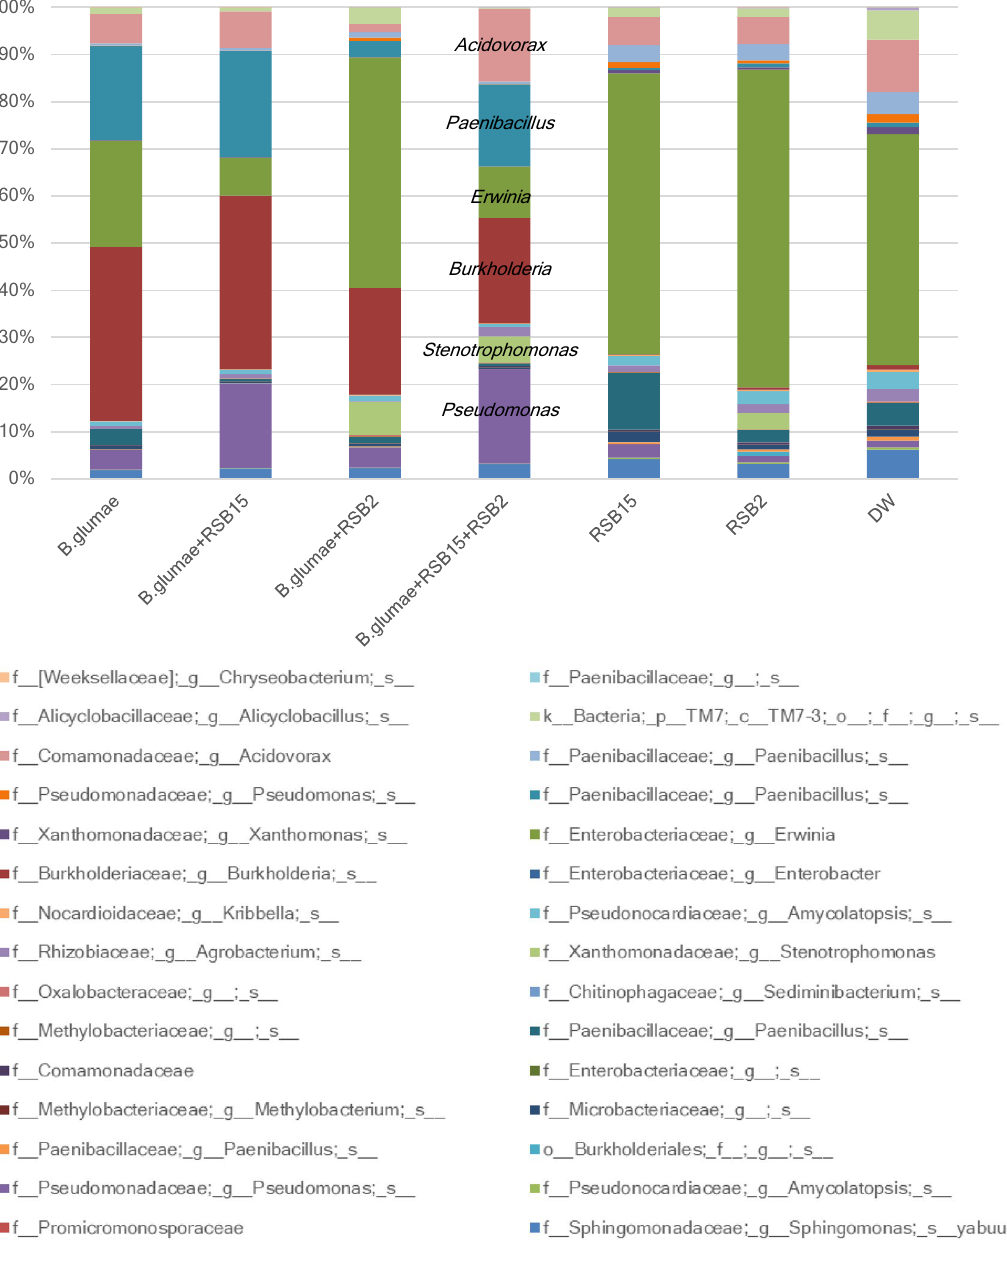
Figure 7. Percentage of OTUs detected in the samples collected from rice seedlings treated with B. glumae and RSB2 and RSB15. Four days after treating non-pregerminated seed with B. glumae (OD = 0.0004) and RSBs (OD = 0.04), twenty-five seedlings collected three times and mixed all of them and ground with liquid- nitrogen, and DNA was extracted for 3 sets (technical replications). Results from the analysis of 16S rRNA gene sequences detected by culture-independent evaluation of rice using next generation sequencing with a MiSeq system (n = 3). Box color pink, Acidovorax ; blue, Paenibacillus ; green, Erwinia ; brown, Burkholderia ; pale green, Stenotrophomonas ; purple, Pseudomonas